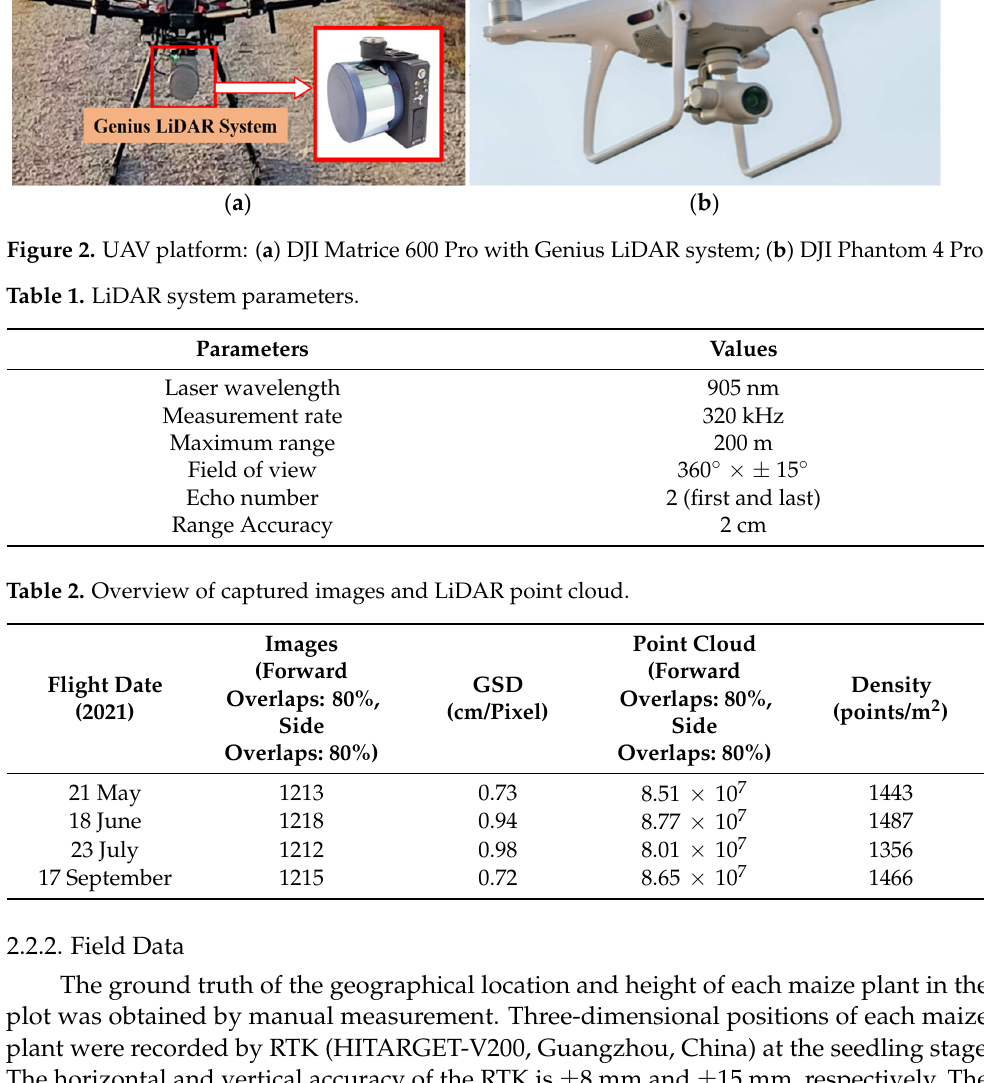
Table 2. Overview of captured images and LiDAR point cloud.